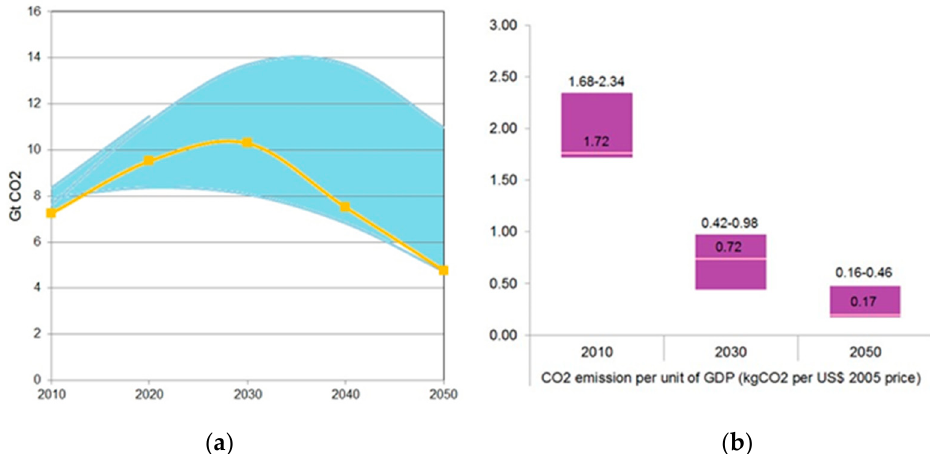
Figure 6. ( a ) Comparison of DDPP and other scenarios: projected CO 2 emissions; and ( b ) carbon intensity of GDP. Notes: The shaded areas represent the range of CO 2 emissions projections in various alternative scenarios reviewed in Section 2. The orange line represents CO 2 emissions projected by the DDPP scenario ( a ). The pink line represents CO 2 emissions per unit of GDP in the DDPP scenario ( b ). The variation of 2010 data is explained by the fact that some of the alternative scenarios used predicted rather than historical data.